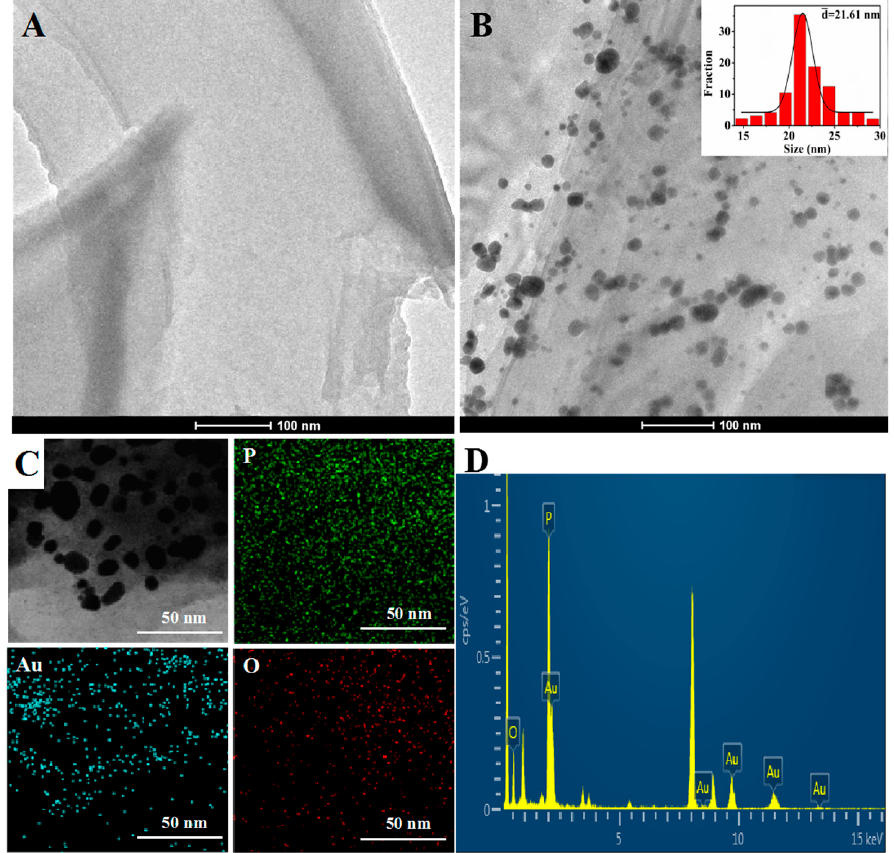
Figure 1. TEM images of BPNS ( A ) and AuNPs–BPNS ( B ). Inset: the size distributions of AuNPs. EDX mappings of P, Au and O in the AuNPs–BPNS ( C ). EDX spectrum of AuNPs–BPNS ( D ).